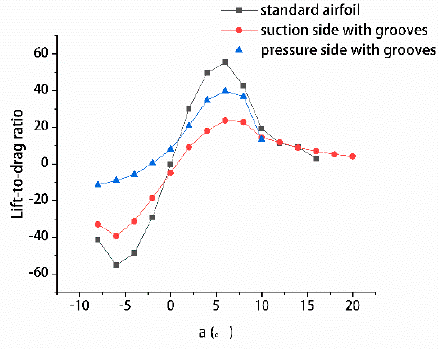
Figure 11. Variation of lift–drag ratio with angle of attack.